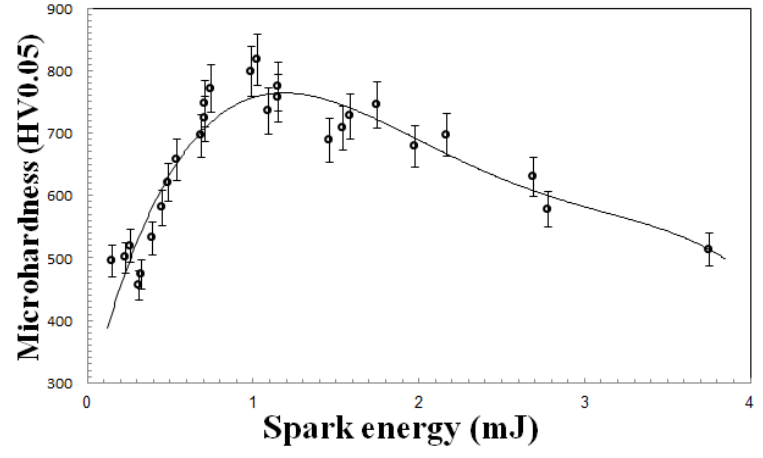
Figure 12. Variation of hardness of coated samples with spark energy in the surface.